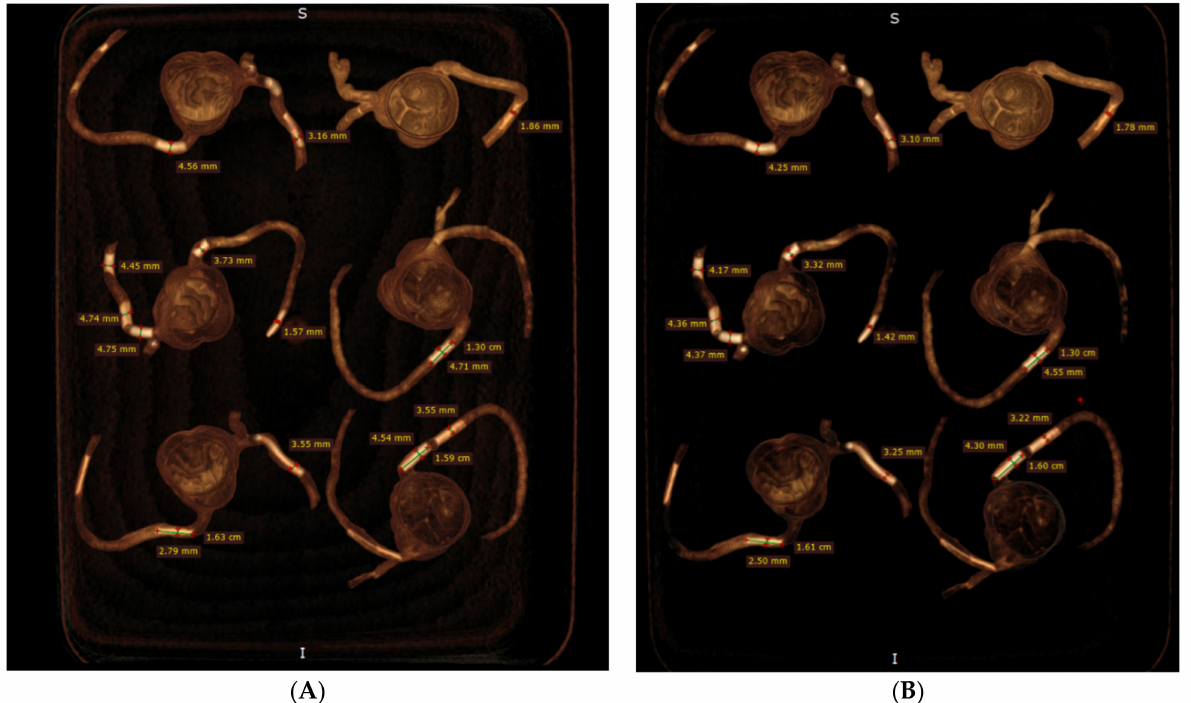
Figure 6. Measurement of plaque dimensions on 3D volume rendering images with the use of different windowing. ( A ) Measurements of plaque dimensions on wide window width (window width and window level: 1250 and 250). ( B ) Measurement of plaque dimensions at the same plaque locations with narrow window width (window width and window level: 1050 and